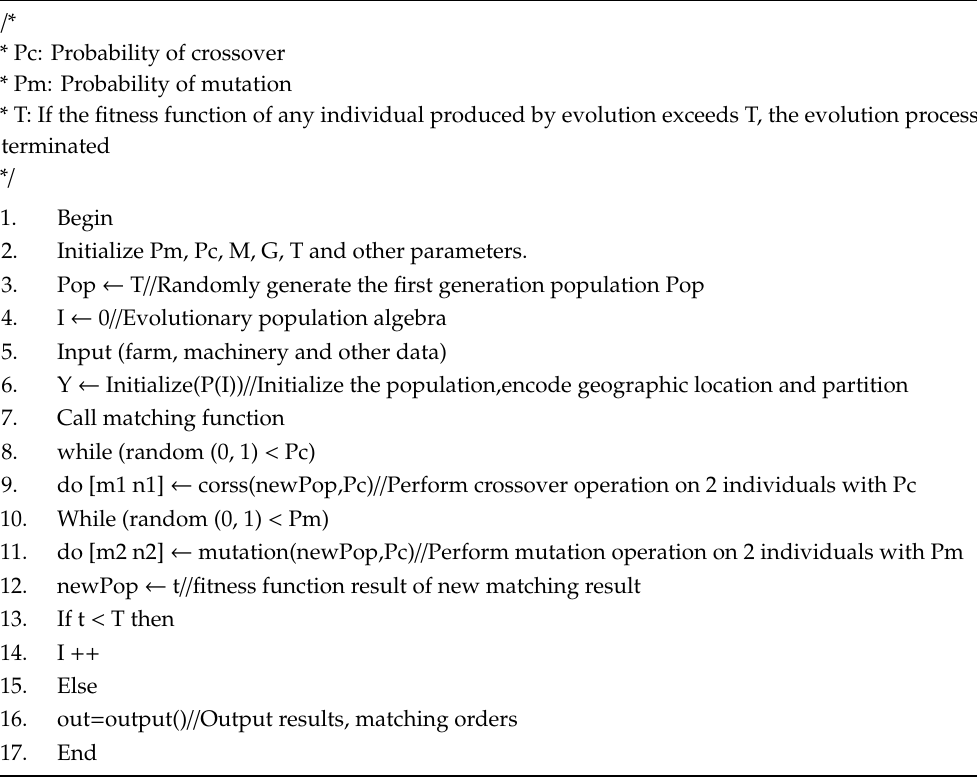
Algorithm 1. Smart contract execution